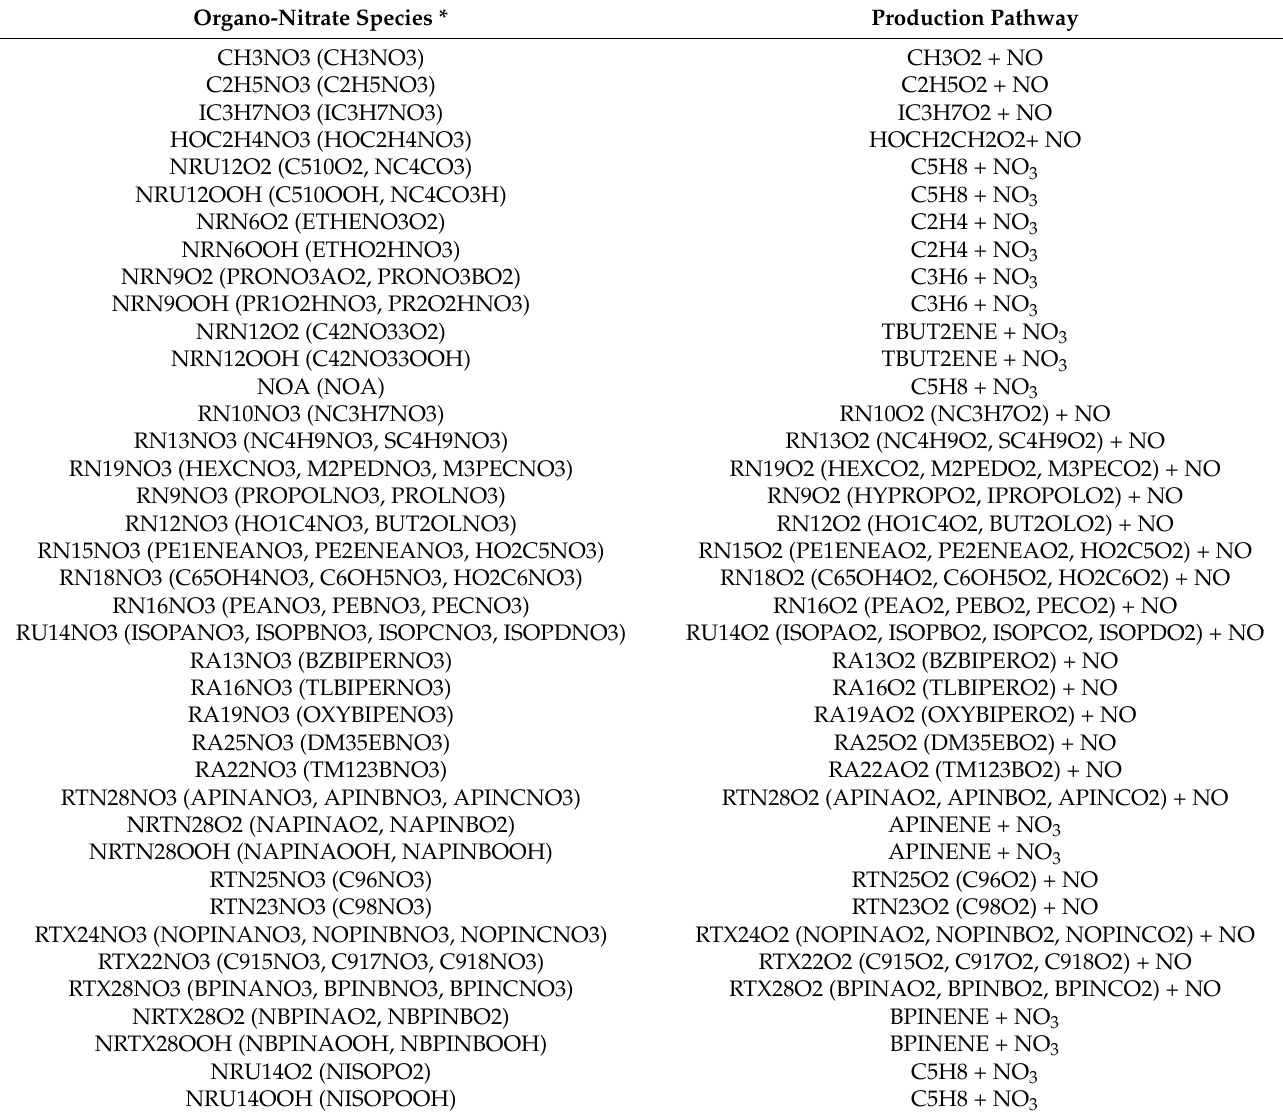
Table 1. Organo-nitrate species (shown in CRI names) and their respective production pathways and precursors, as represented in the CRI-v2 mechanism of